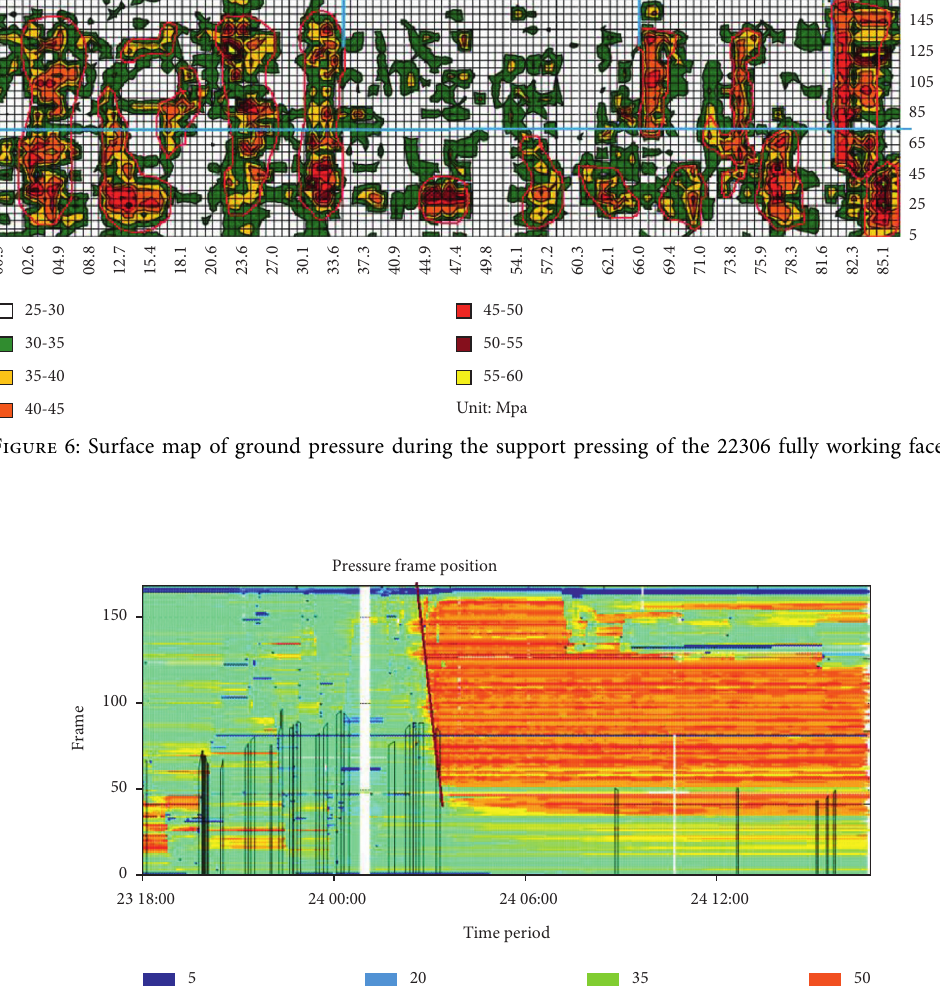
Normal periodic pressure